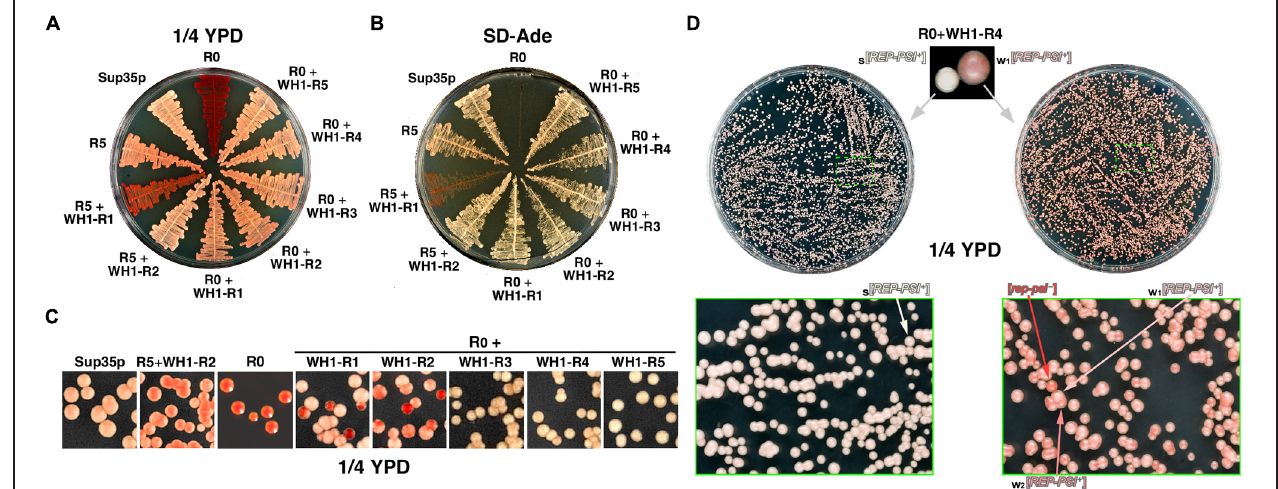
FIGURE 2 | WH1-Rn/Sup35p chimeras constitute a novel functional prion, [ REP-PSI + ]. (A) A yeast strain carrying the ade1-14 reporter was transformed with the chimeras ( Figure 1B ). Transformants were streaked on 1 / 4 YPD and grown at 30 ◦ C for ≥ 72 h. Except for R5 + WH1-R1, all the other chimeras restore a [ PSI + ]-like color phenotype. (B) Same clones as in (A) were plated on selective dropout medium lacking adenine (SD-Ade). A [ PSI + ]-like stop codon read-through phenotype was confirmed for the chimeras, although very weak for R5 + WH1-R1. (C) After several passages in YPD, clones in (A) were plated on 1 / 4 YPD (top) unveiling the instability (red sectored